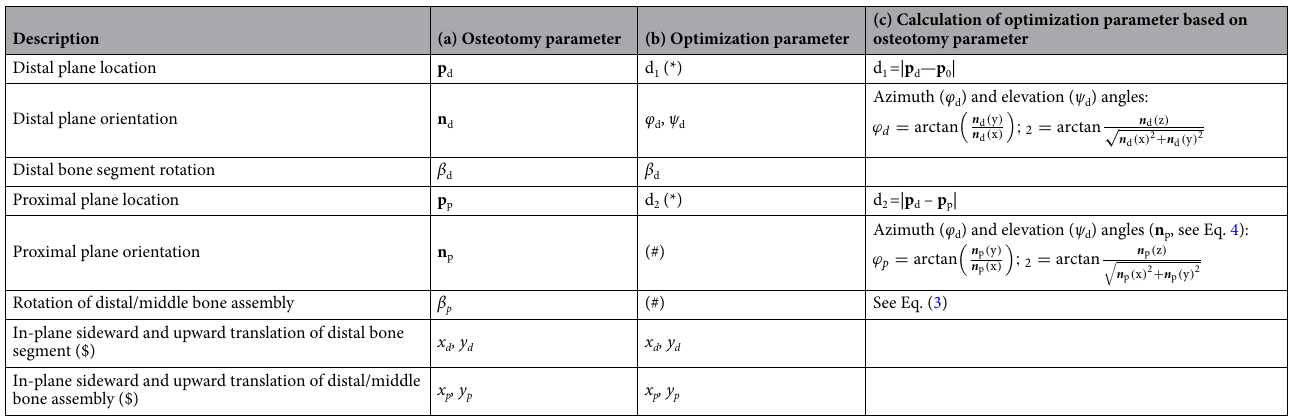
Table 1. (a) The osteotomy parameters which are involved in the application of an ODCRO and their relation with (b) optimization parameters visualized in Figs. 1b and 5. In this example the distal plane is chosen by the algorithm, the proximal plane parameters can then be calculated. (c) Shows how these optimization parameters are calculated. (*) Measured along the gravitation axis of the target bone (see text). (#) proximal plane follows distal plane (see Eqs. 3 and 4). ($) Measured along the two gravitation axes of the points describing the distal or proximal bone cross section (Fig. 5b).